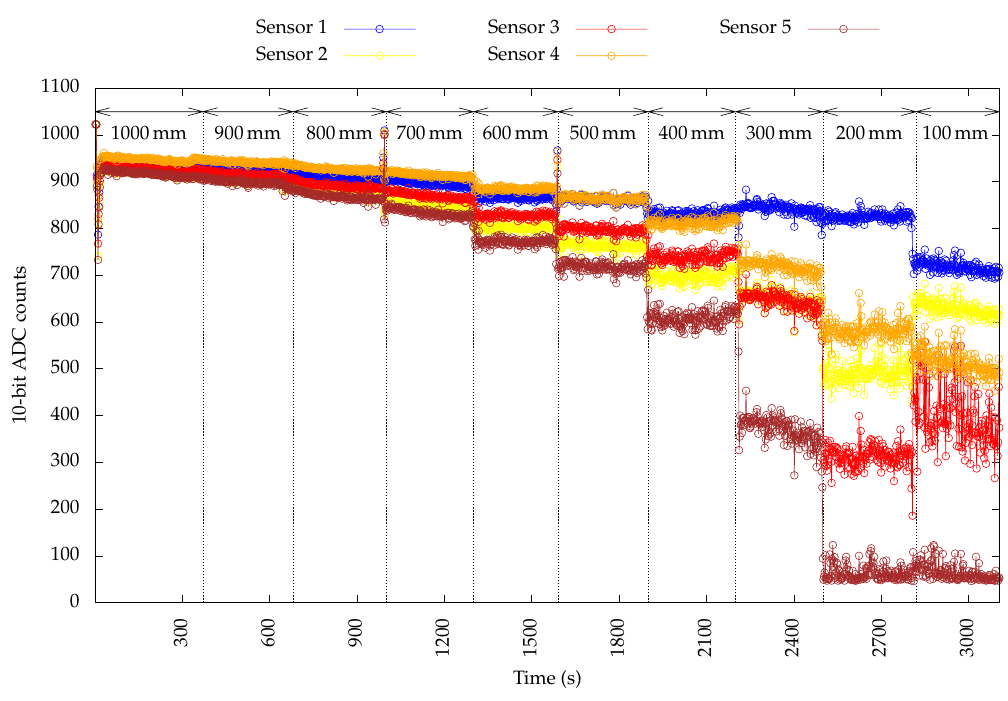
Figure 10. Flame sensors data.